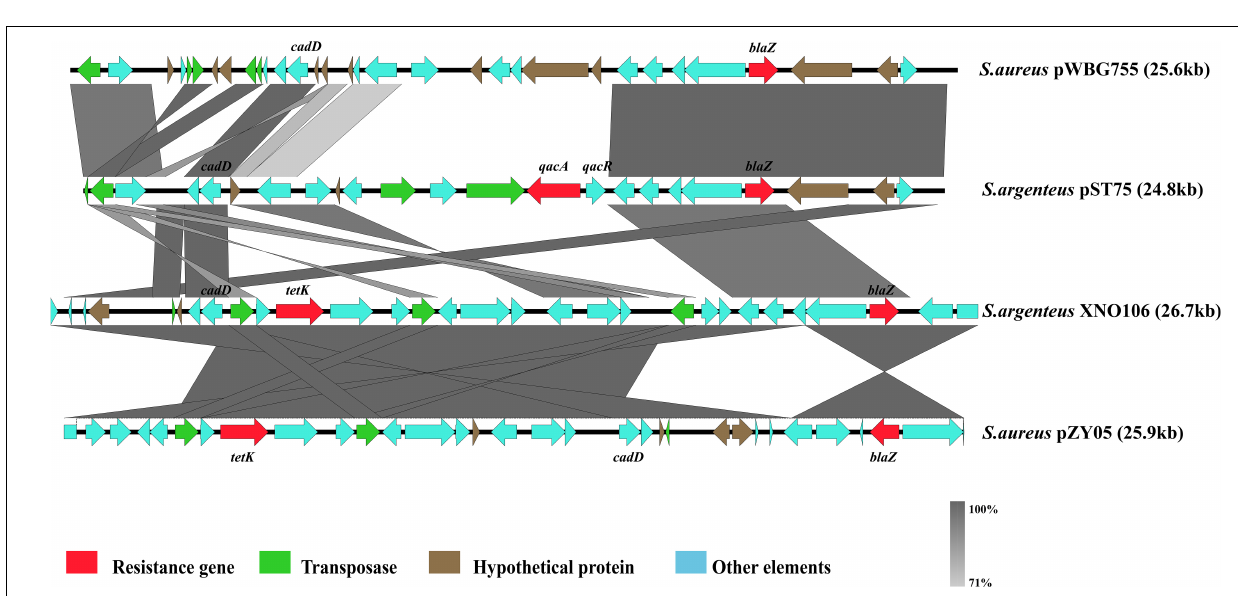
FIGURE 5 | Schematic representation comparing two plasmids described in S . argenteus with other similar plasmids found in S . aureus .